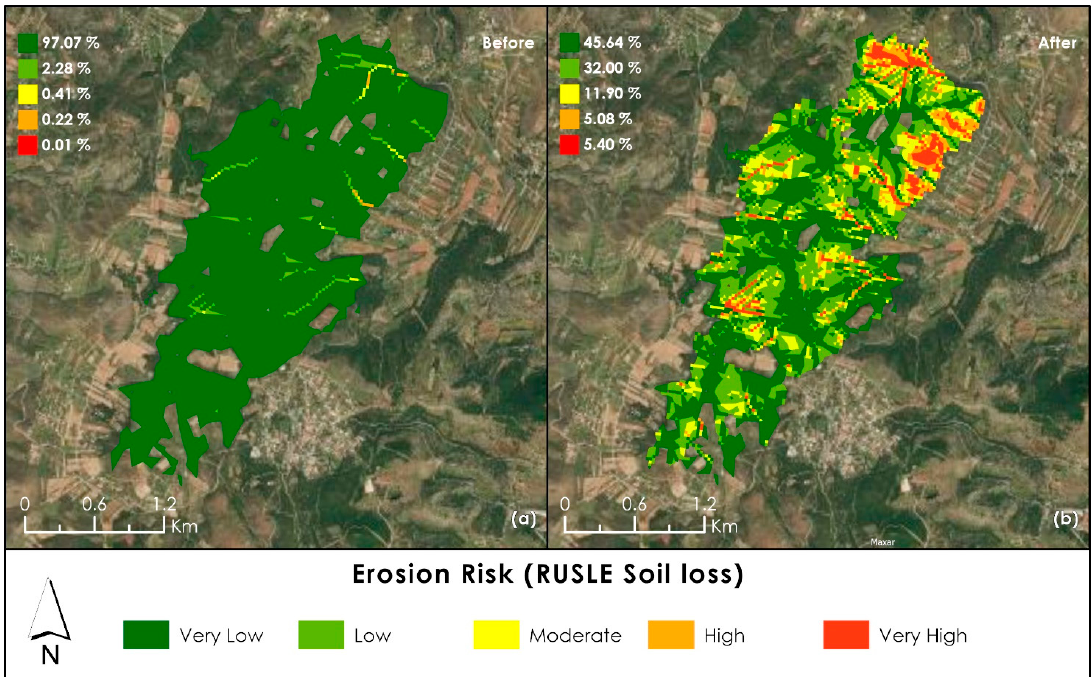
Figure 7. Erosion risk according to RUSLE soil loss for Lavreotiki burned area: ( a ) before the fire; ( b ) after the fire. The erosion risk as classified is presented including the percentage of the burned area total of each area per class.